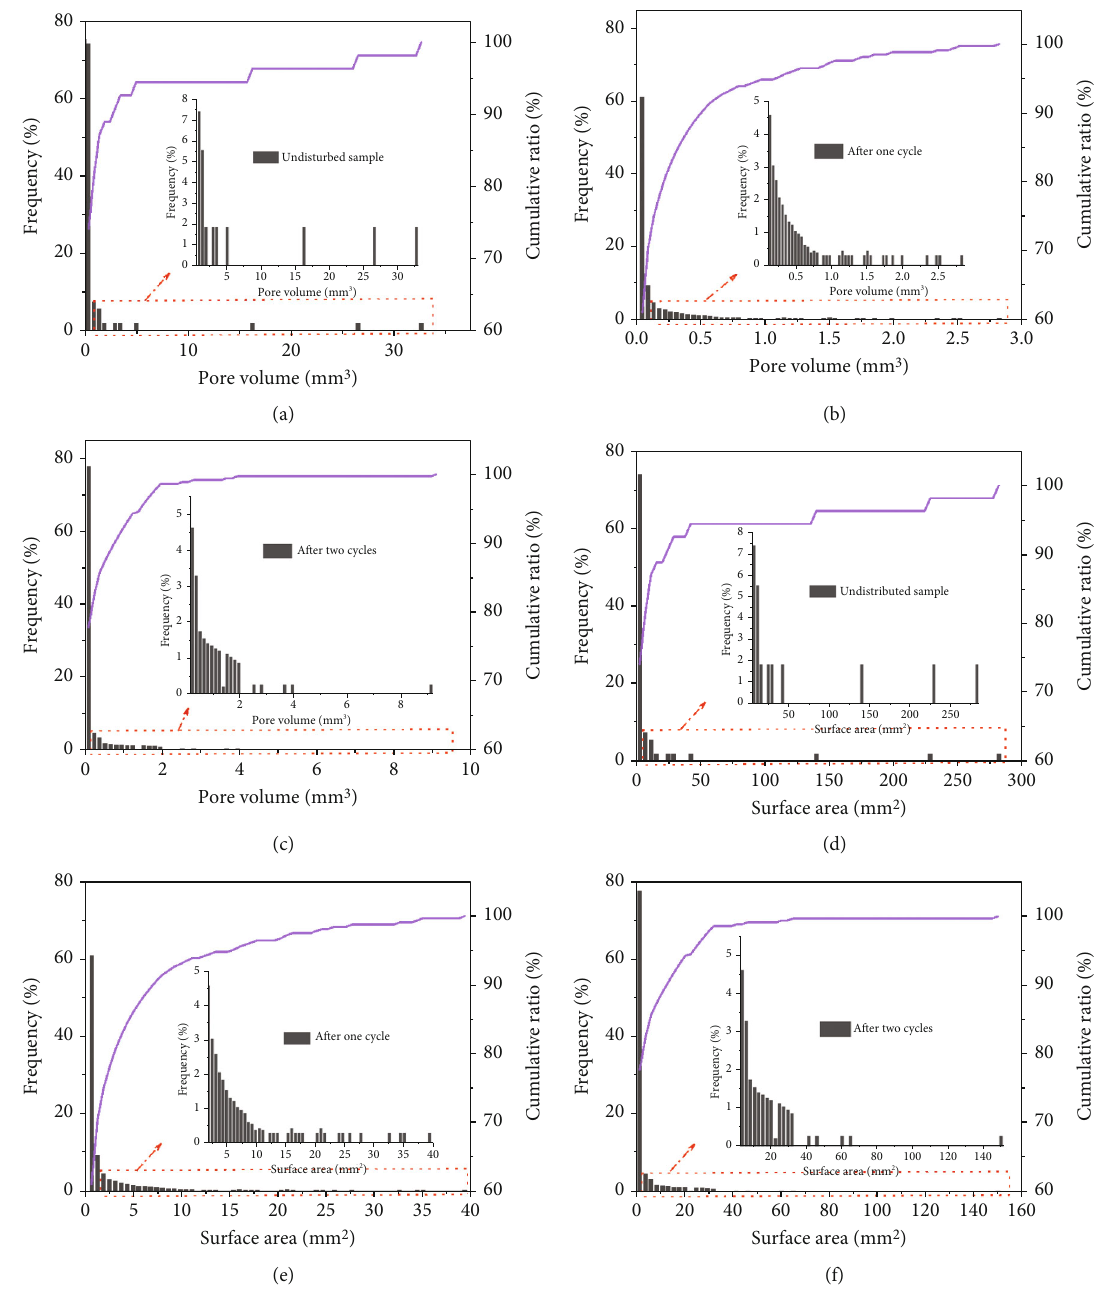
Figure 14: Statistics of pore parameters: (a) pore volume of undisturbed sample; (b) pore volume of fi rst cycle; (c) pore volume of second cycle; (d) surface area of undisturbed sample; (e) surface area of fi rst cycle; (f) surface area of second